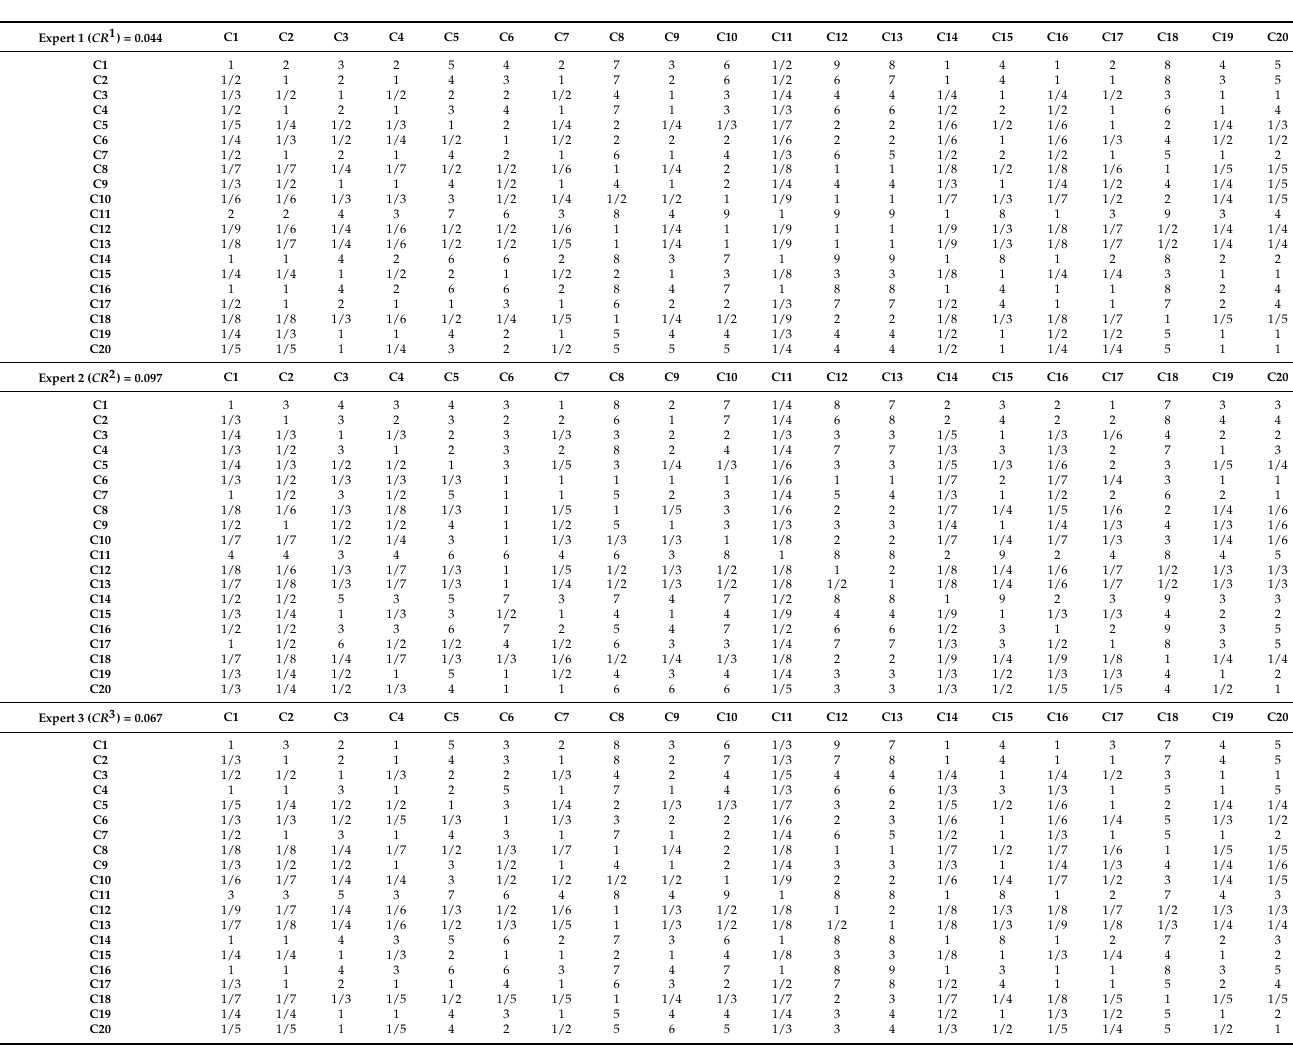
Table A2. Individual pair-wise comparison matrices of the